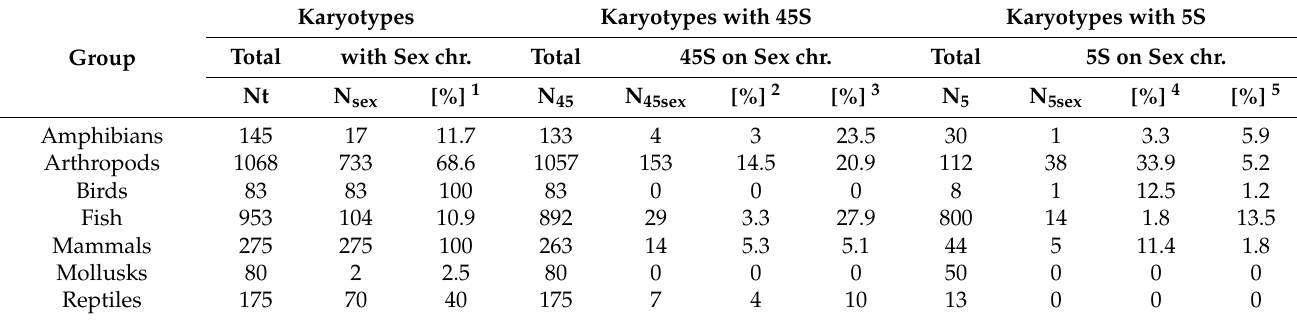
Table 2. Frequency of 5S and 45S rDNA localization on sex